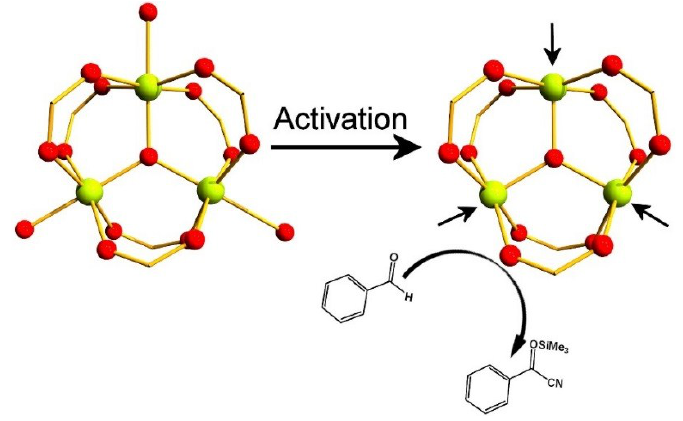
Figure 14. The coordinated water molecules are removed from MIL-101(Cr) generating free coordination sites (highlighted with black arrows) during the activation process. Subsequently, the activated MIL-101(Cr) catalyses the cyanosilylation of benzaldehyde. (Colour scheme: Fe, lime green; O, red).